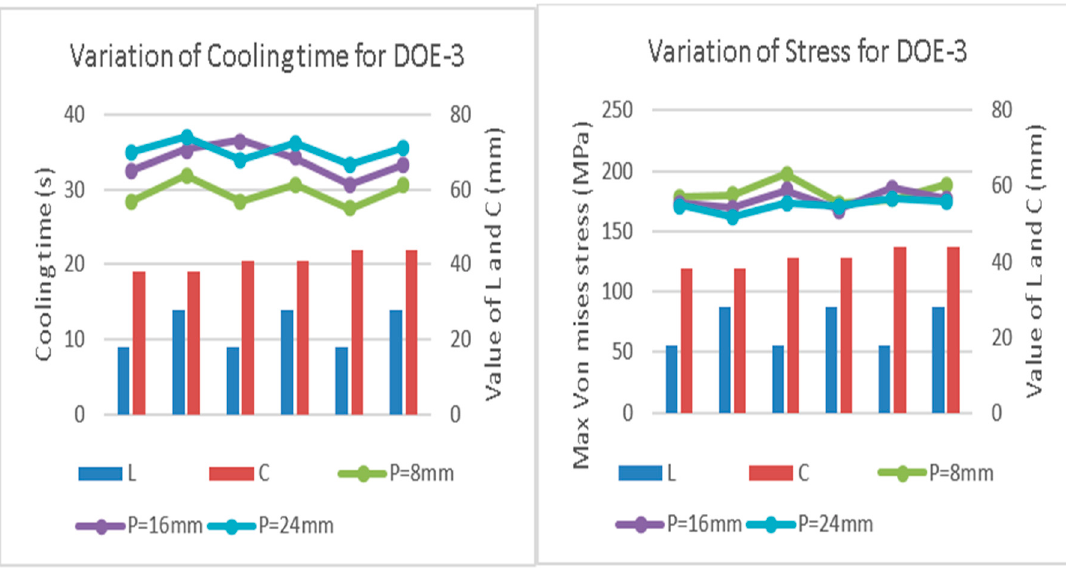
Figure 5. Trend of cooling time and maximum von Mises stress variation in DOE-3.